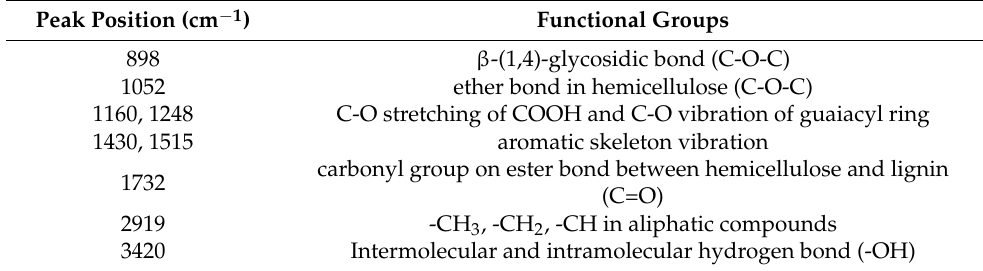
Figure 6. FTIR spectra for pretreated and untreated corn stover. Table 2. Peak assignment from FTIR